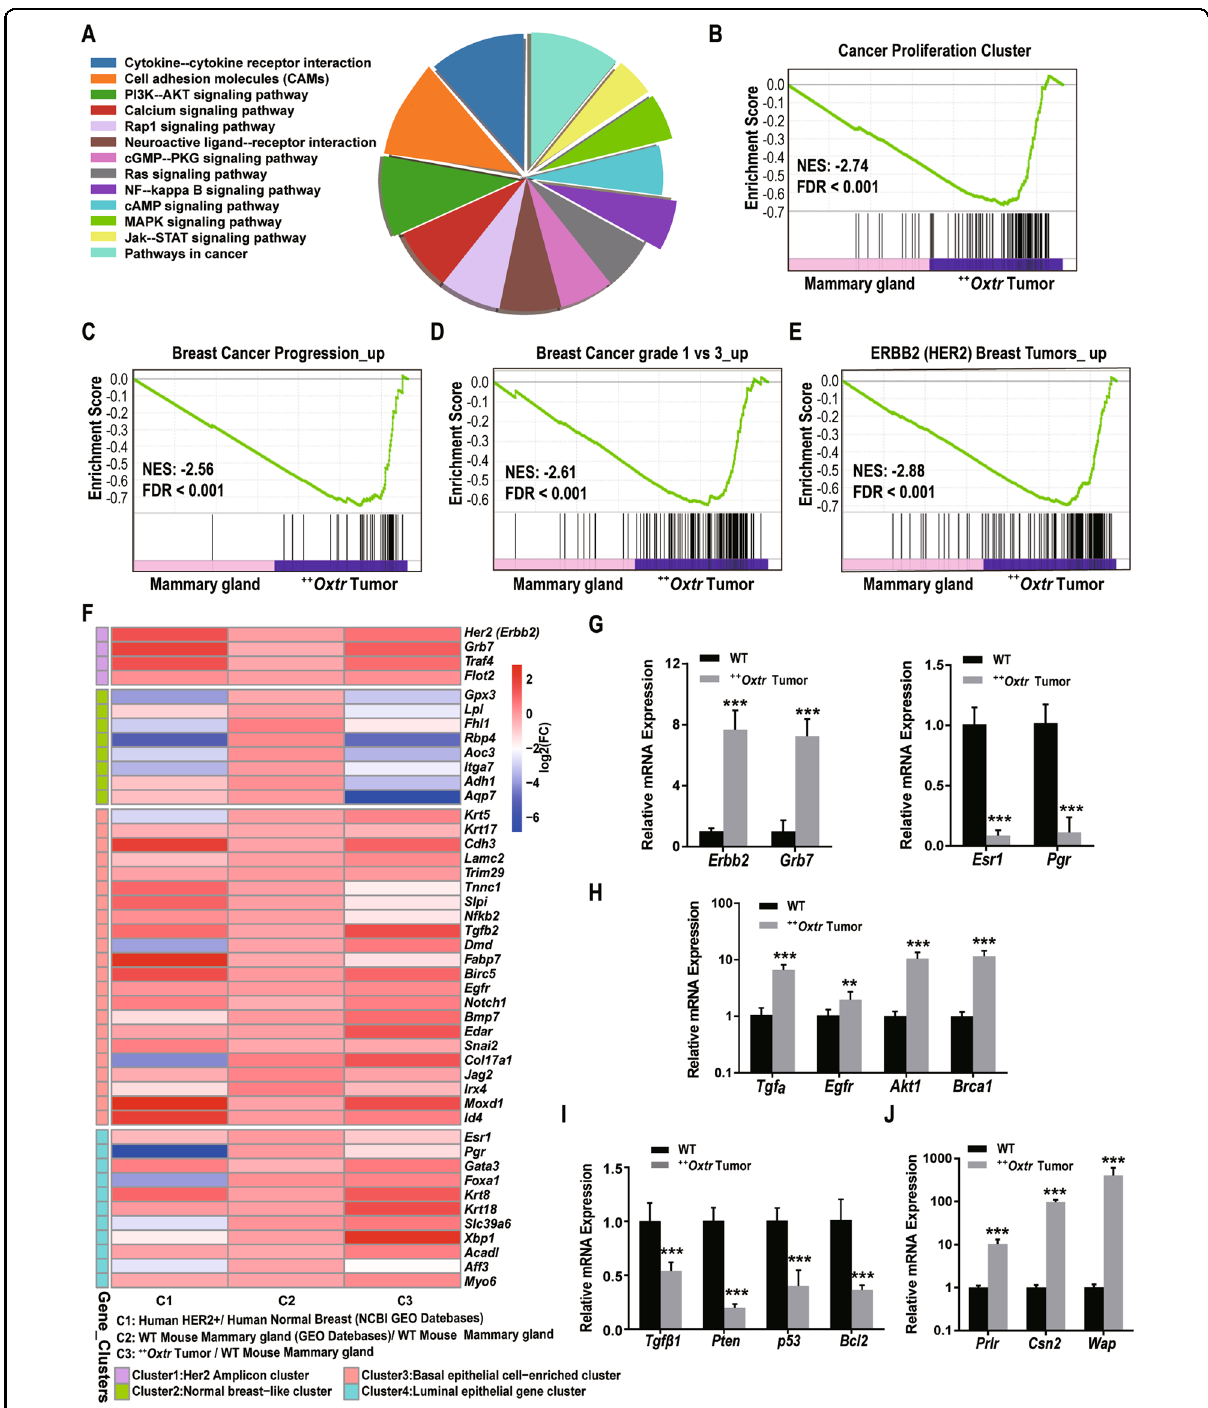
Fig. 3 Identi fi cation of Erbb2 positive mammary tumors by differentially expressed genes (DEGs). A Pie chart representation of KEGG pathway enrichment of DEGs between ++ Oxtr tumors to WT mammary gland. B – E Gene set enrichment analysis (GSEA) showed upregulated genes of cancer proliferation cluster ( B ), breast cancer-related pathways ( C , D ), and ERBB2 breast cancer-related pathways ( E ) were signi fi cantly enriched in ++ Oxtr tumors. Signi fi cance was determined by normalized enrichment score (NES) and FDR. F Heatmap representation of gene expression patterns in human HER2 + breast cancer patients to normal breast 3 (Data from GSE61) and ++ Oxtr tumors to WT mammary gland. G Validation of RNAseq results by qPCR. Gene expression of Erbb2 , Grb7 , Esr1 , and Pgr , n = 6. H Gene expression of Tgfa , Egfr , Akt1 , and Brca1 , n = 6. I Gene expression of Tgf β 1 , Pten , p53 , and Bcl2 , n = 6. J Gene expression of Prlr , Csn2 , and Wap , n = 6. Data were represented as mean ± SD. ** P < 0.01, *** P < 0.001, calculated using two-tailed unpaired t